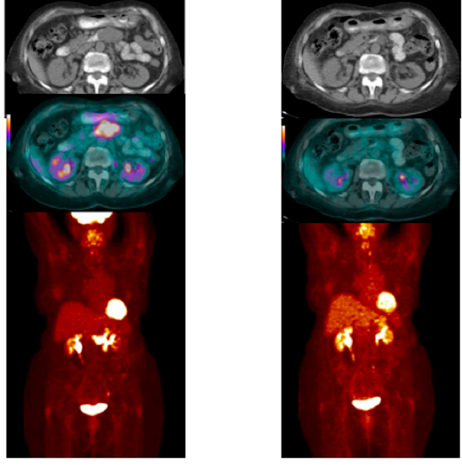
Figure 3. Pre- and Post FDG PET in an 82 old female with gastro-intestinal stromal tumor (GIST). Baseline FDG/PET study was performed off tyrosine kinase inhibitor therapy and she was initiated on a therapy. Repeat study was performed two weeks after initiation of Gleevec ® (Imatinib) a specific c-KIT inhibitor. Both anatomic and metabolic response was seen. Although there was still a residual anatomic abnormality, the tumor had complete metabolic response. This illustrates that the power of early functional imaging.